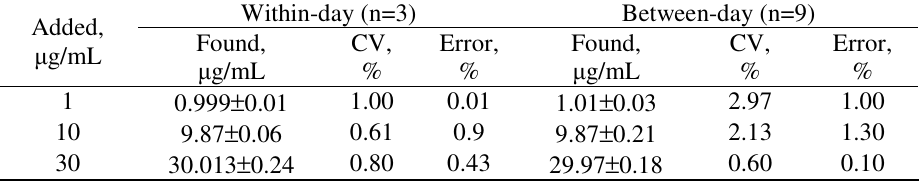
Table 3. Accuracy and precision data of determination of nickel (1-30 µ g/mL) in the presence of copper (10 µ g/mL) by third- derivative